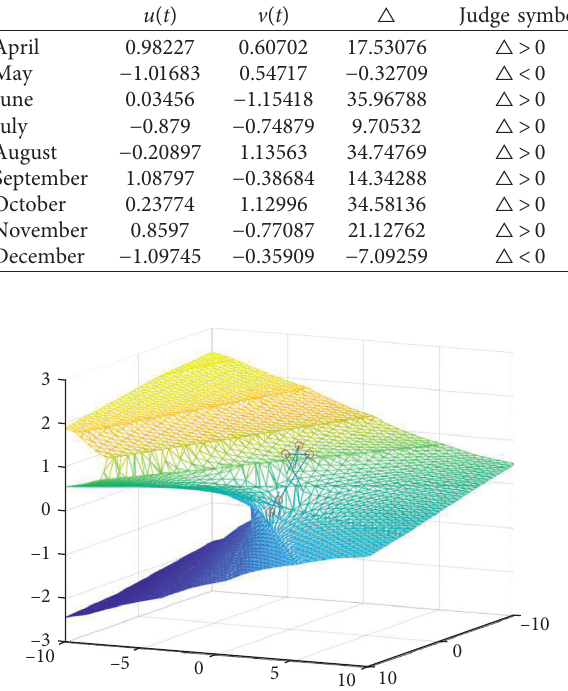
Figure 4: Three-dimensional renderings of sudden changes in Shanghai crude oil futures prices in 2018.